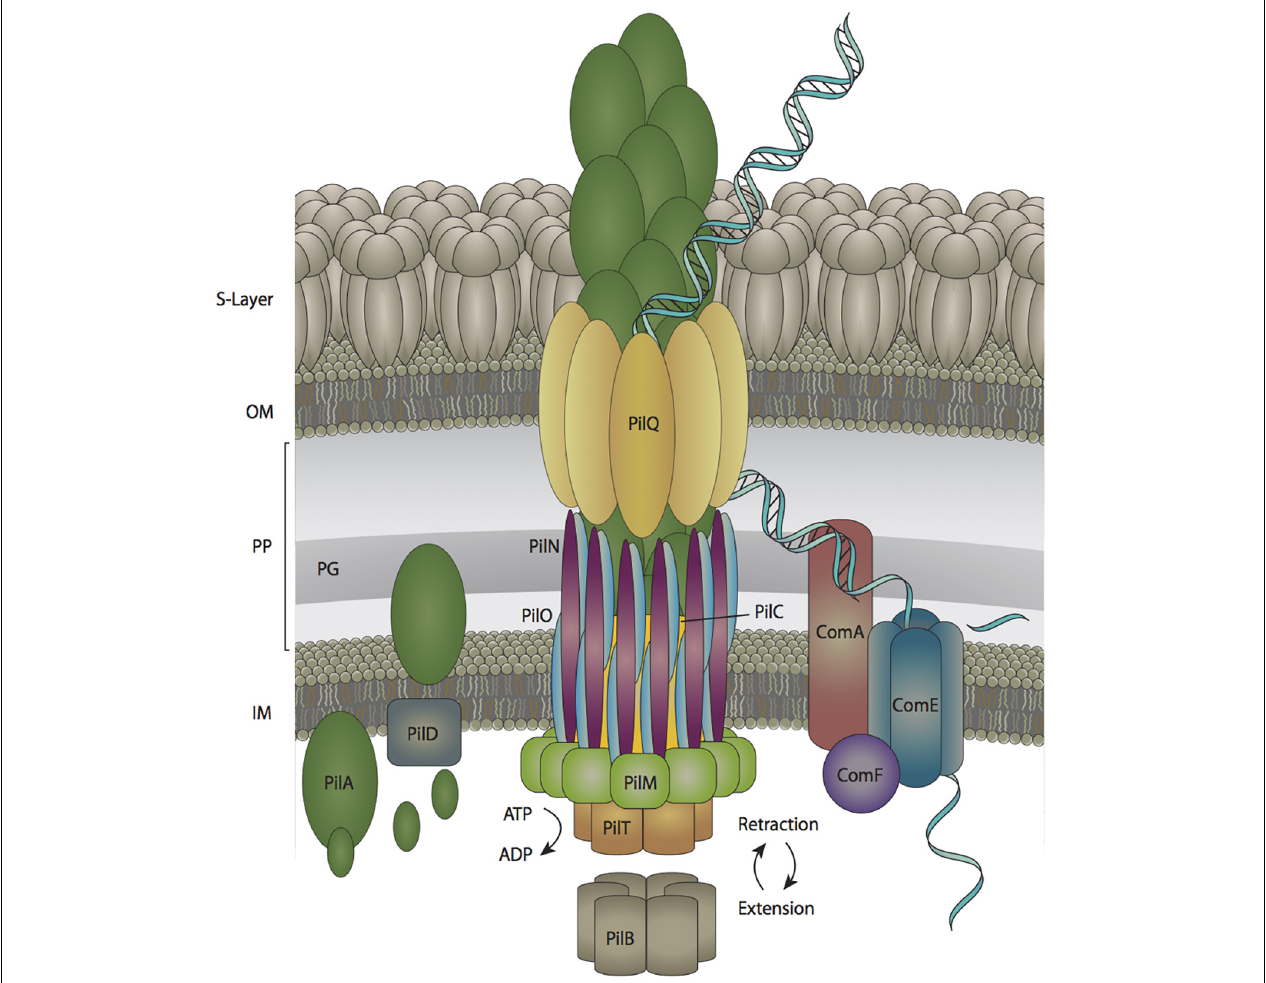
FIGURE 1 | The DNA uptake apparatus in Synechocystis sp. PCC 6803. DNA enters the periplasm through an outer membrane pore composed of PilQ subunits. The double stranded DNA is then converted to single-stranded form prior to traversing the inner membrane pore, which is composed of ComE subunits. S-Layer is the surface layer, OM is the outer membrane, PP is the periplasm, PG is the peptidoglycan layer, and IM is the inner